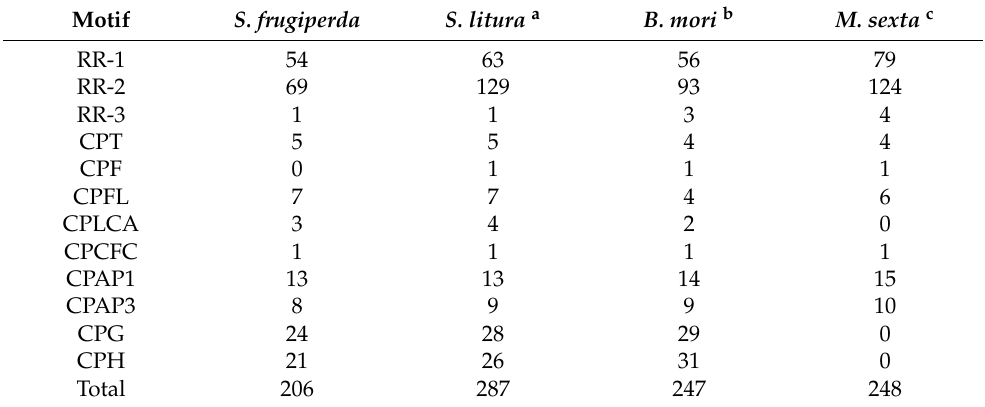
Table 1. Summary of the gene number of each cuticular protein family in Spodoptera frugiperda , S. litura , Bombyx mori and Manduca sexta